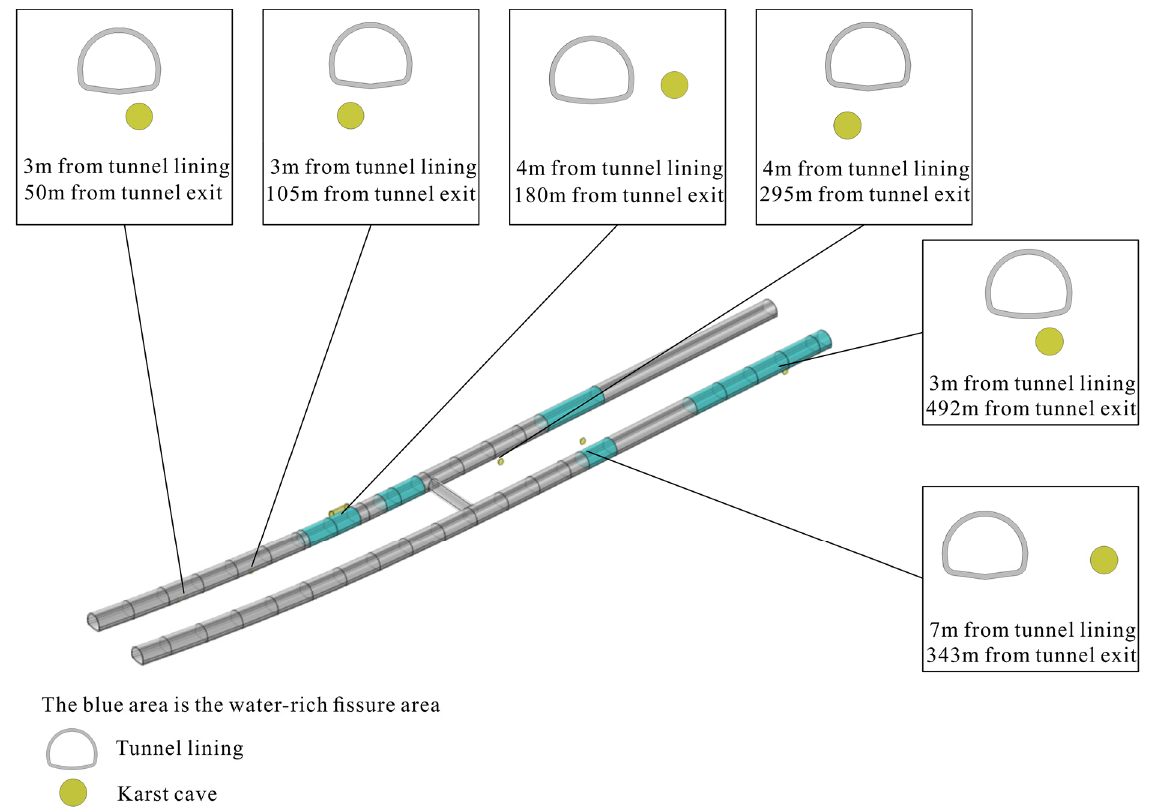
Figure 3. Schematic diagram of radar survey results.